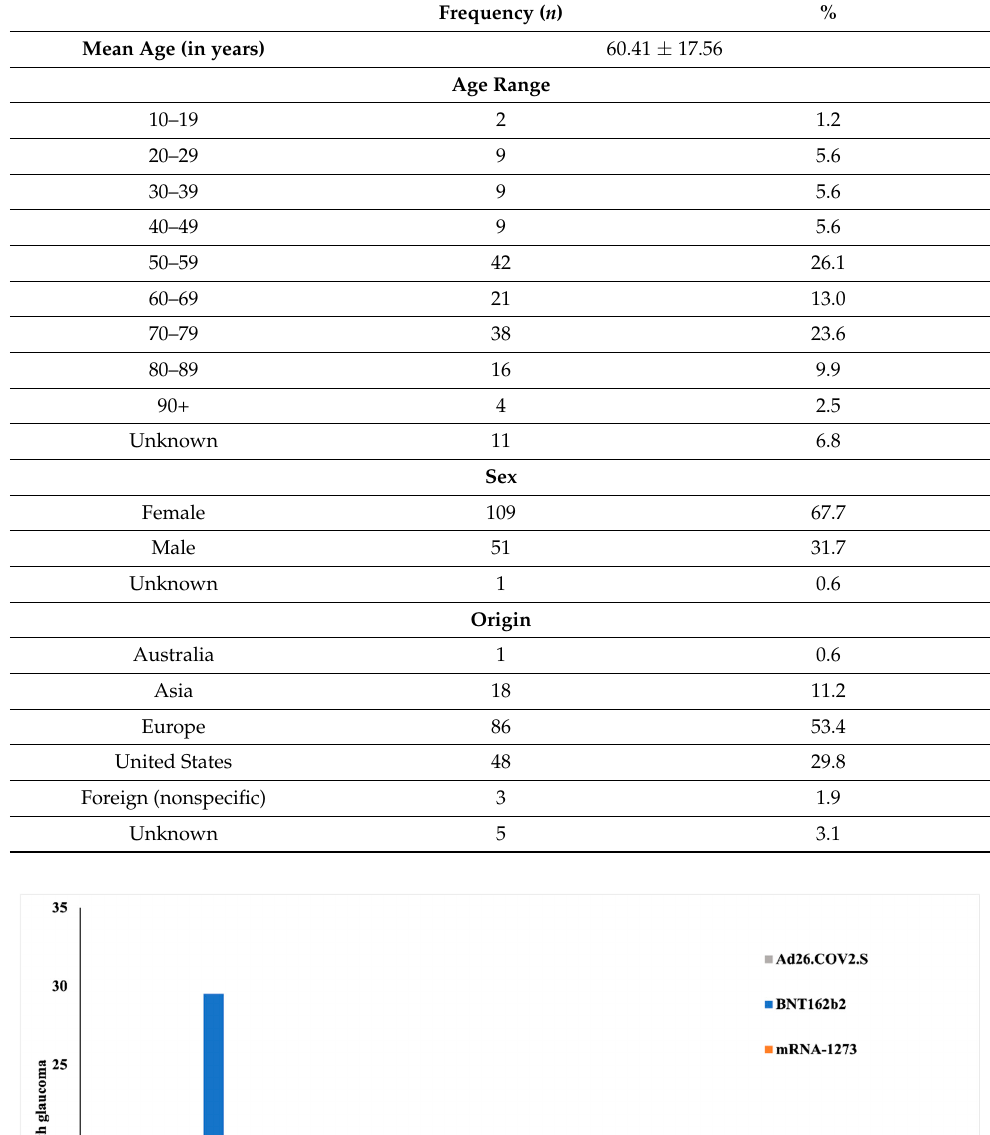
Table 1. Demographics of patients who were diagnosed with glaucoma following SARS-CoV-2 vaccination.